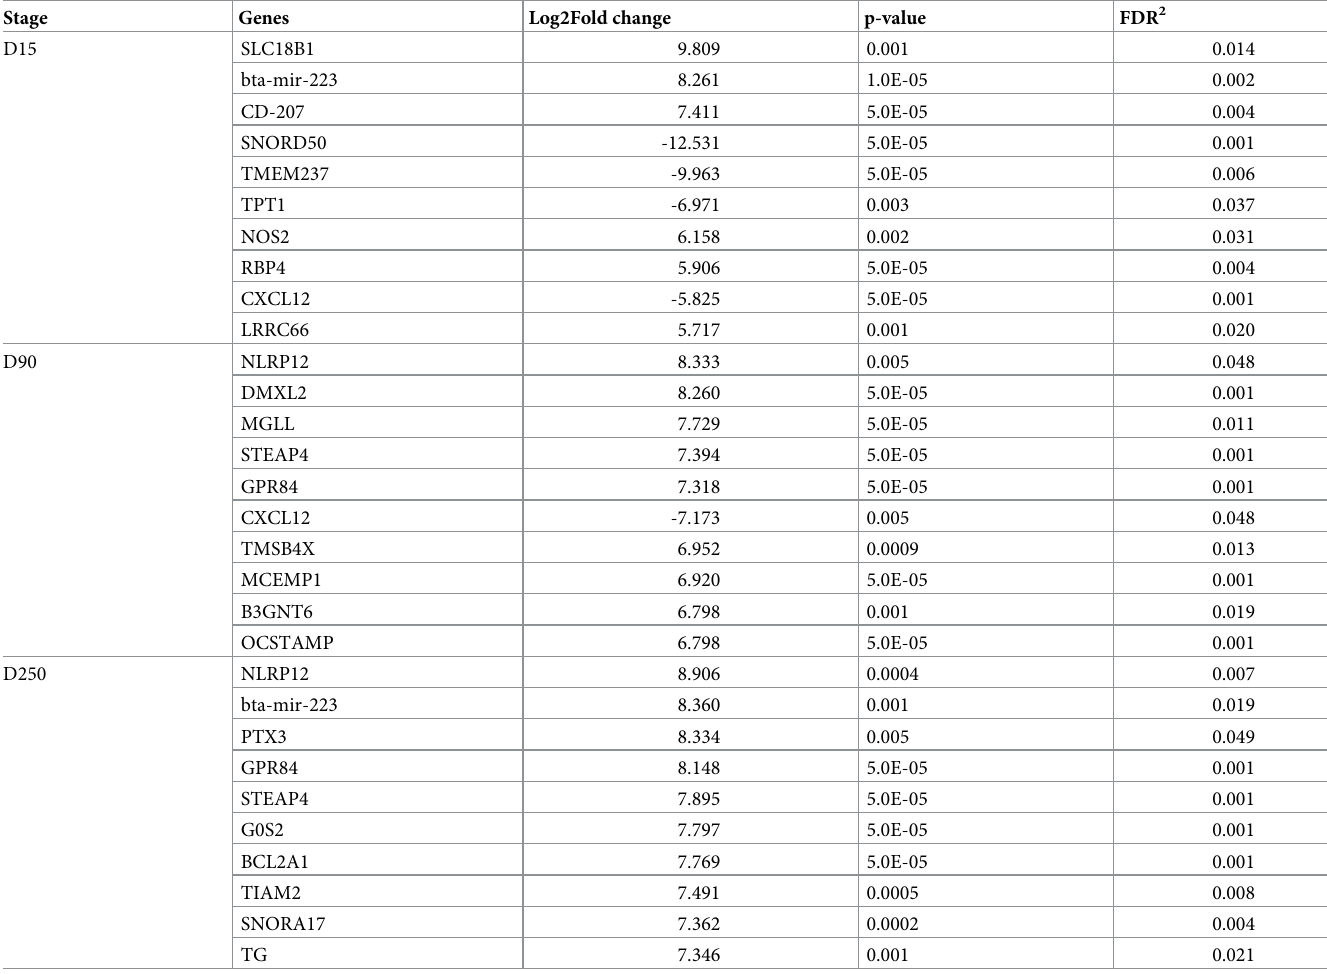
Table 4. Top differentially expressed genes in mammary epithelial cells with highest fold changes between Kashmiri and Jersey cattle 1 .